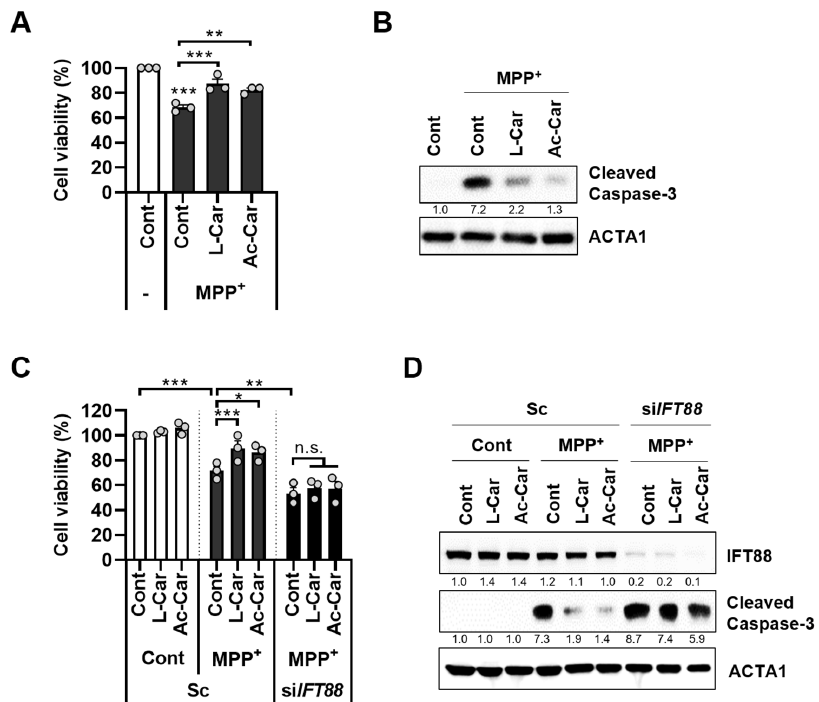
Figure 3. Carnitine inhibits MPP + -induced neurotoxicity by enhancing ciliogenesis in SH-SY5Y cells. ( A , B ), SH-SY5Y cells were treated with MPP + (2.5 mM) in the presence or absence of L-carnitine (L-Car, 100 µM) or Ac-L-carnitine (Ac-Car, 100 µM) for 24 h. Then, cell viability was measured by a CCK-8 assay (A). The cells were further analyzed by western blotting with cleaved caspase-3 antibody ( B ). ( C , D ), SH-SY5Y cells were transiently transfected with either scrambled siRNA (Sc) or targeted siRNA for IFT88 (si IFT88 ). The cells were then treated with MPP + (2.5 mM) in the presence or absence of L-carnitine (100 µM) or Ac-L-carnitine (100 µM) for an additional 24 h. Cell death was measured using a CCK-8 assay ( C ), and western blotting was performed with indicated antibodies ( D ). Data are presented as the mean ± SEM ( n = 3, * p < 0.05, ** p < 0.01, *** p < 0.001, n.s. = not significant).